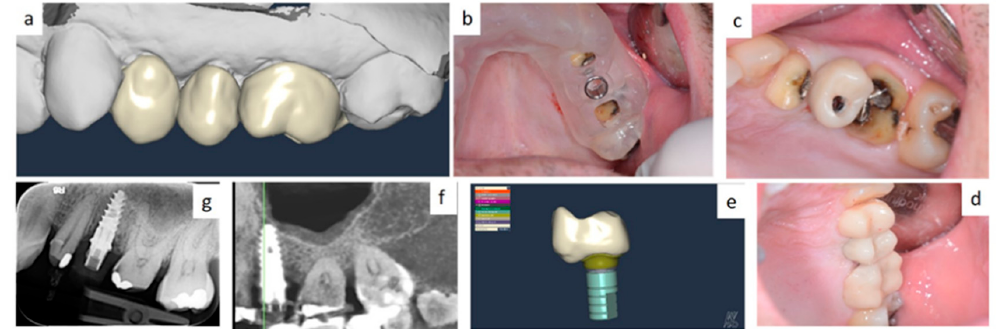
Figure 3. Single tooth restoration by screw-retained crown digitally planned by computer aided design (CAD) and CBCT ( a ); implant insertion was assisted by a surgical guide ( b – e ); fixture position was pre-operatively planned by simulation of crestal sinus membrane elevation ( f , g ).